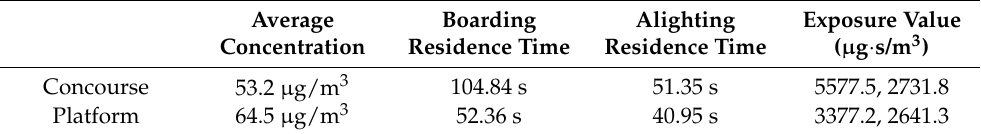
Table 7. PM2.5 Exposure Calculation Results Using Average Concentration.